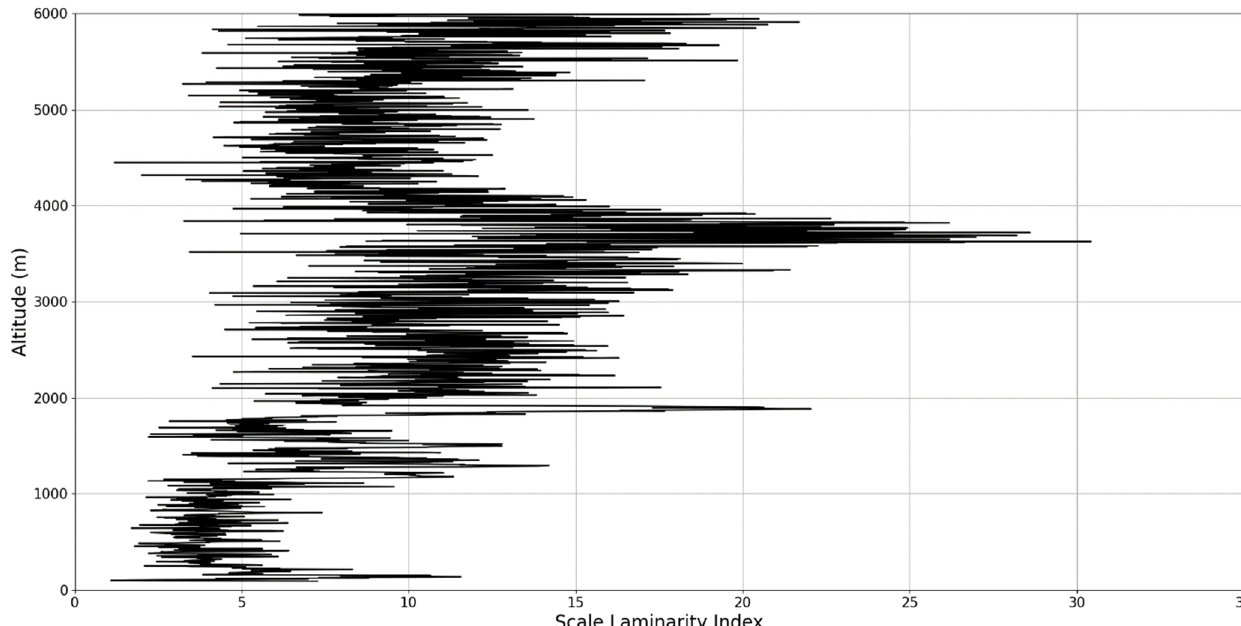
Figure 26. Scale laminarity index profile plot corresponding to point A.